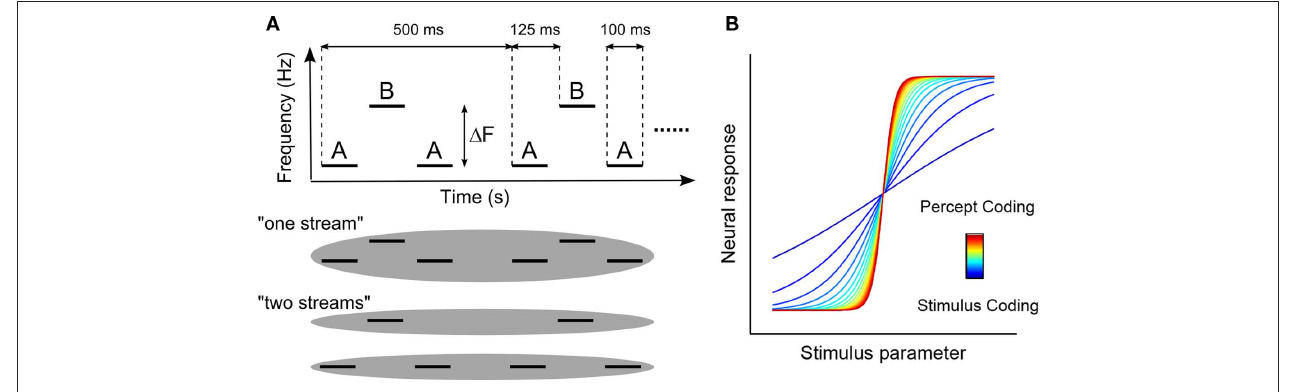
between 500 and 1000 Hz. (B) Conceptual model of varying neural responses to parametric manipulation of the acoustic parameter (frequency separation). A linear variation of the neural response is to be expected if that response is coding the stimulus parameter, whereas a sigmoidal (i.e., categorical) response is to be expected if the response is coding the